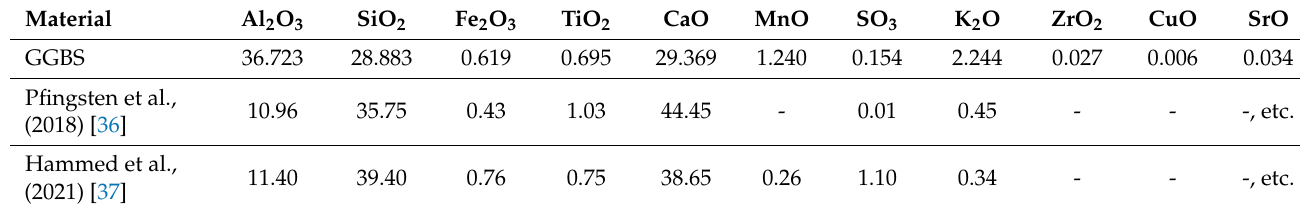
Table 4. Chemical composition of ground granulated blast furnace slag.